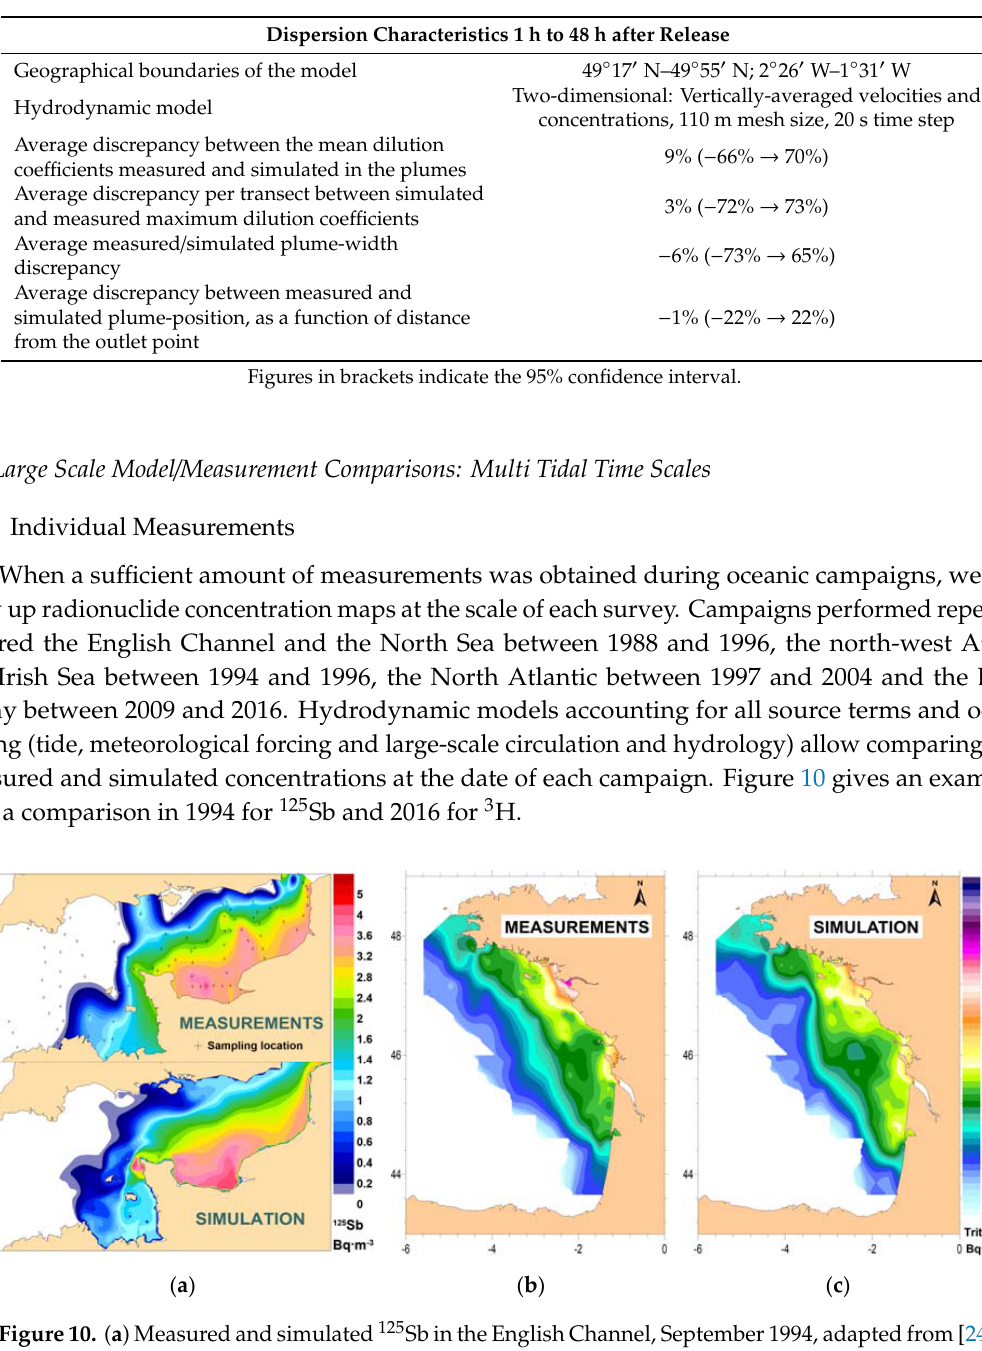
Table 2. Characteristics of the model used to simulate soluble radioactive release dispersion in seawaters at a short scale next to an outfall around the Hague Cape.